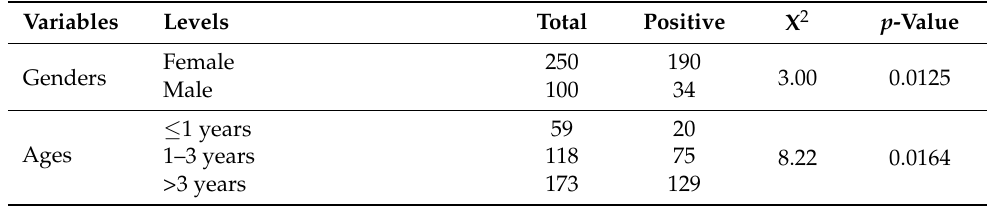
Table 2. Tick infestation on the hosts’ gender, ages, hosts, year-round, and collection sites.